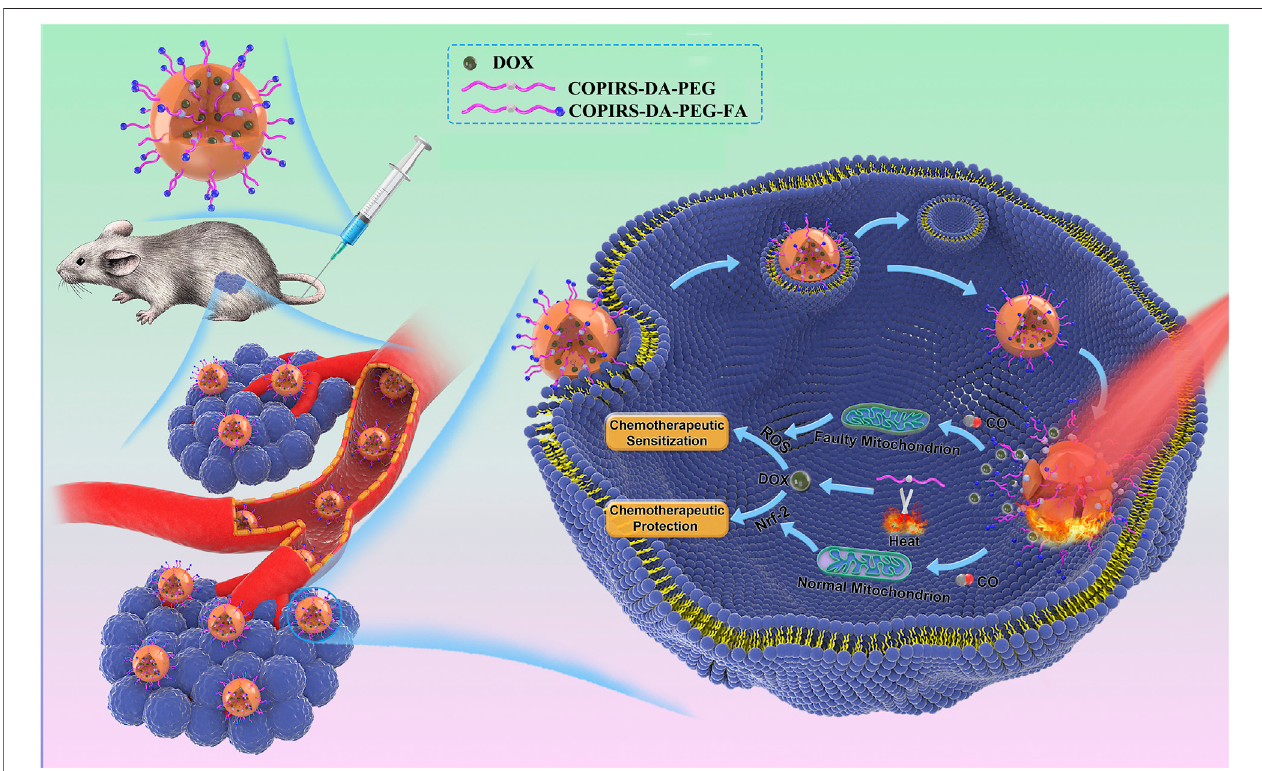
FIGURE1| Afteraccumulation inthetumor and endocytosis bytumor cells, thenanomedicine could synergistically controltherelease ofCOand drugsunderNIR irradiation. CO can distinguish between tumor and normal cells through differences between their mitochondria and regulates their resistance, simultaneously achieving an enhancement of the ef fi cacy of chemotherapy drugs on tumor cells and chemotherapeutic protection on normal